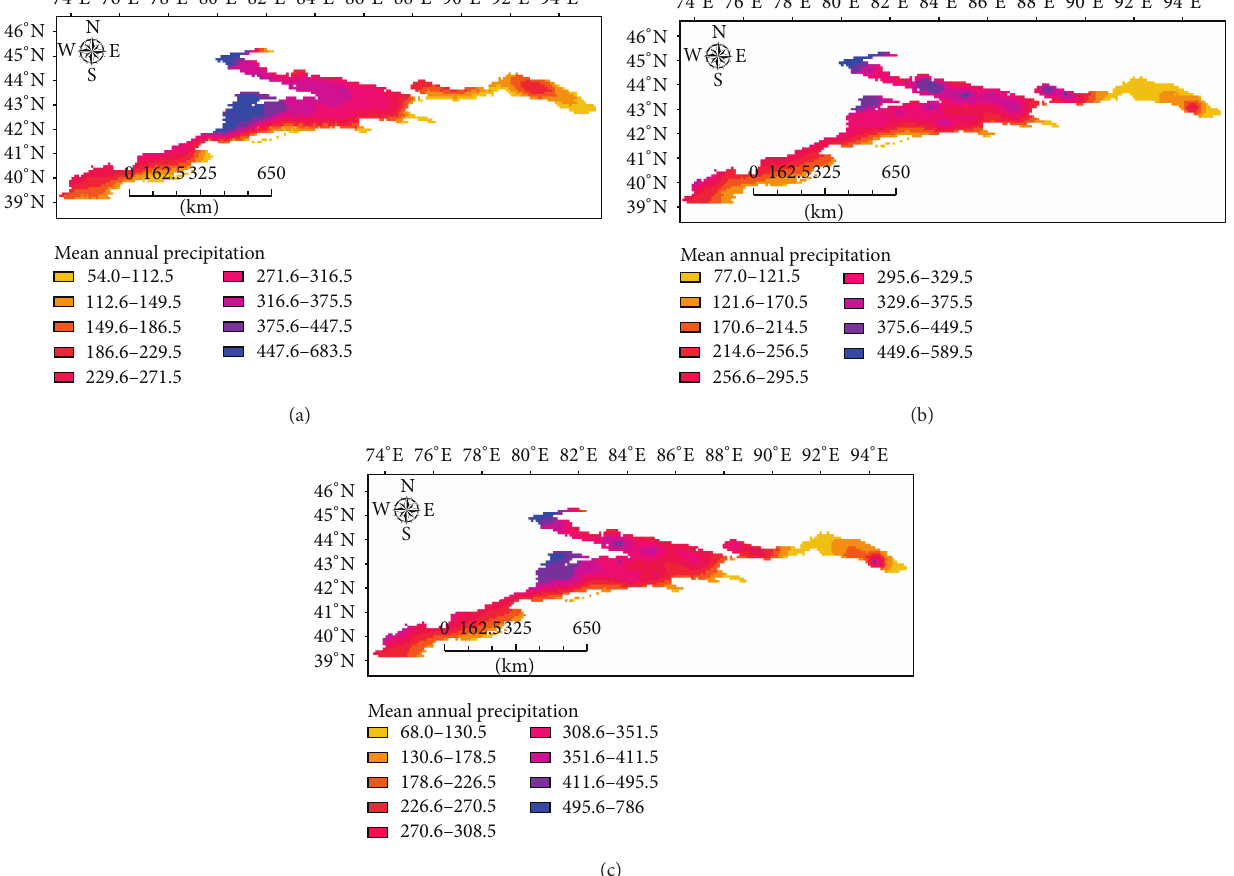
Figure 2: Spatial distribution of mean annual precipitation during 1998 ∼ 2007. (a) APHRODITE V1003R1, (b) 3B43 V6, and (c) 3B43 V7.